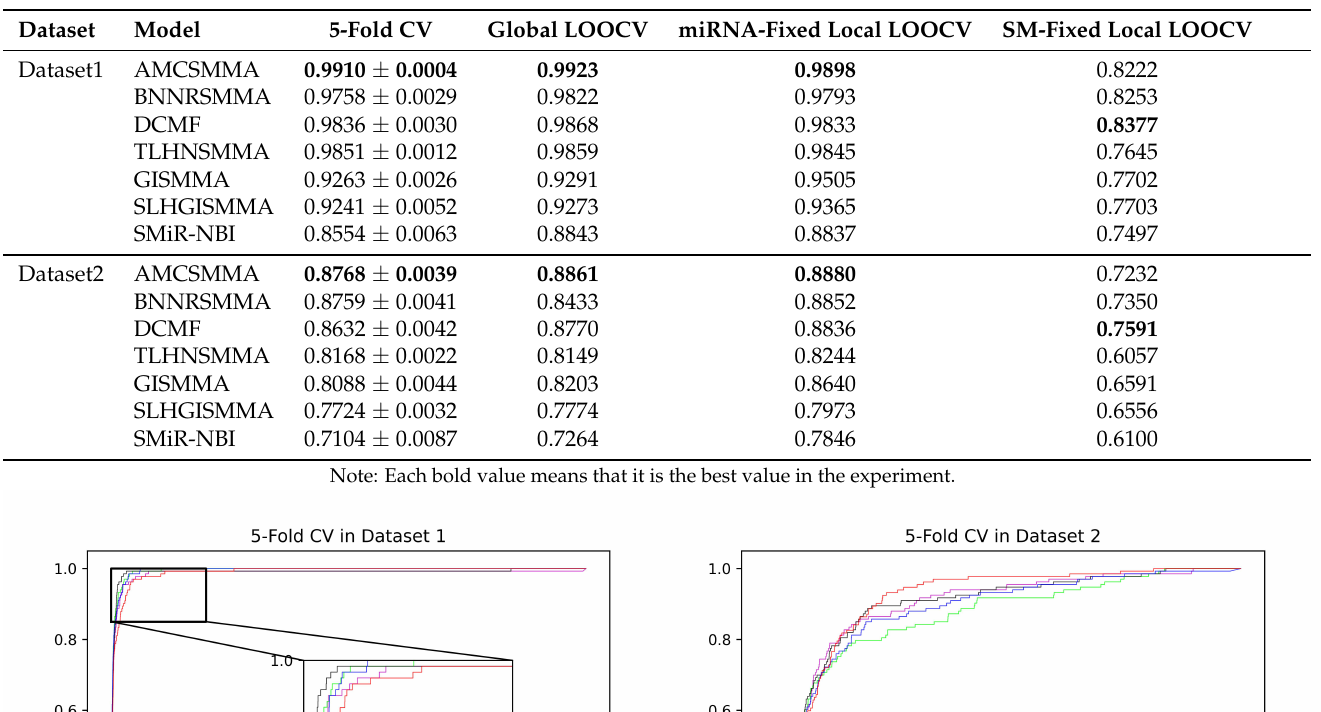
Table 4. The result comparison in terms of the AUC values between AMCSMMA, BNNRSMMA, DCMF, TLHNSMMA, GISMMA, SLHGISMMA, and SMiR-NBI in four kinds of cross-validation experiments based on two datasets.